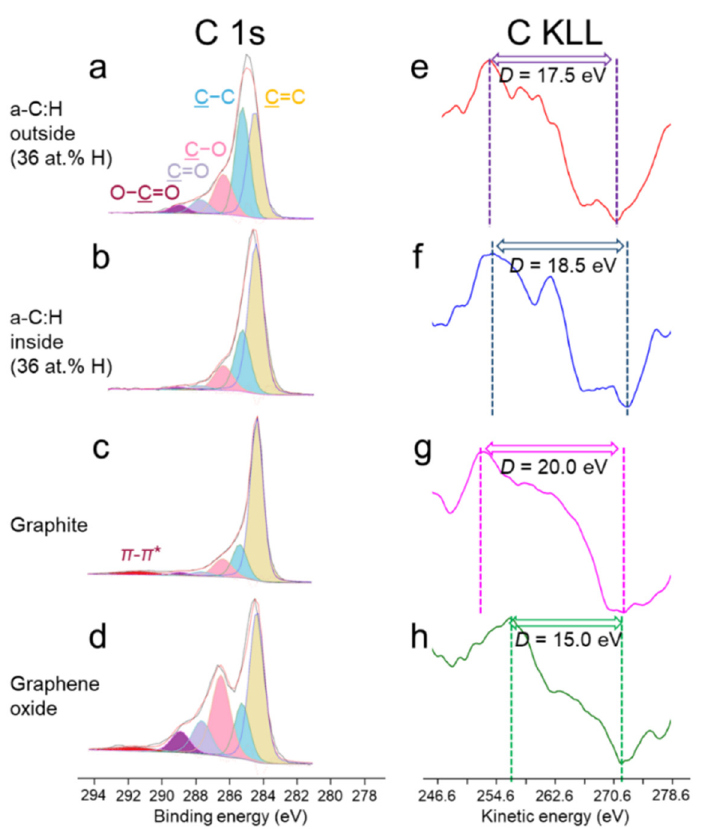
Figure 5. C1s XPS spectra recorded ( a ) outside and ( b ) inside the wear scare of the a-C:H-coated 430 steel disk after sliding. C1s XPS spectra recorded for ( c ) graphite and ( d ) graphene oxide. First-de- 431 rivative C KLL XAES spectra recorded ( e ) outside and ( f ) inside the wear track of the a-C:H-coated steel disk after sliding. First-derivative XAES C KLL spectra recorded for ( g ) graphite and ( h ) graphene oxide. The D parameter is defined as the kinetic energy difference between the maximum and minimum points in the first derivatives of the XAES C KLL spectra.